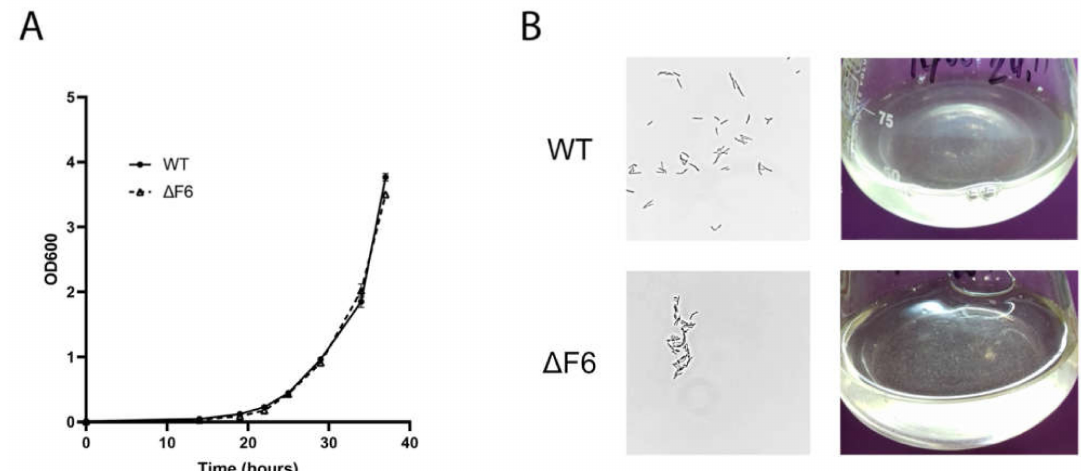
Figure 1. ( A ) Growth curves of M. smegmatis wt and ∆ F6 in Sauton’s medium supplemented with 0.05% ( v / v ) Tween 80. The data are presented as the mean ± SD of three independent experiments. ( B ) Light microscopy image of wt and ∆ F6 M. smegmatis cells in the early-log phase; magnification × 1250 (left panels) and the image of wt and ∆ F6 cultures growing in liquid media (right panels).